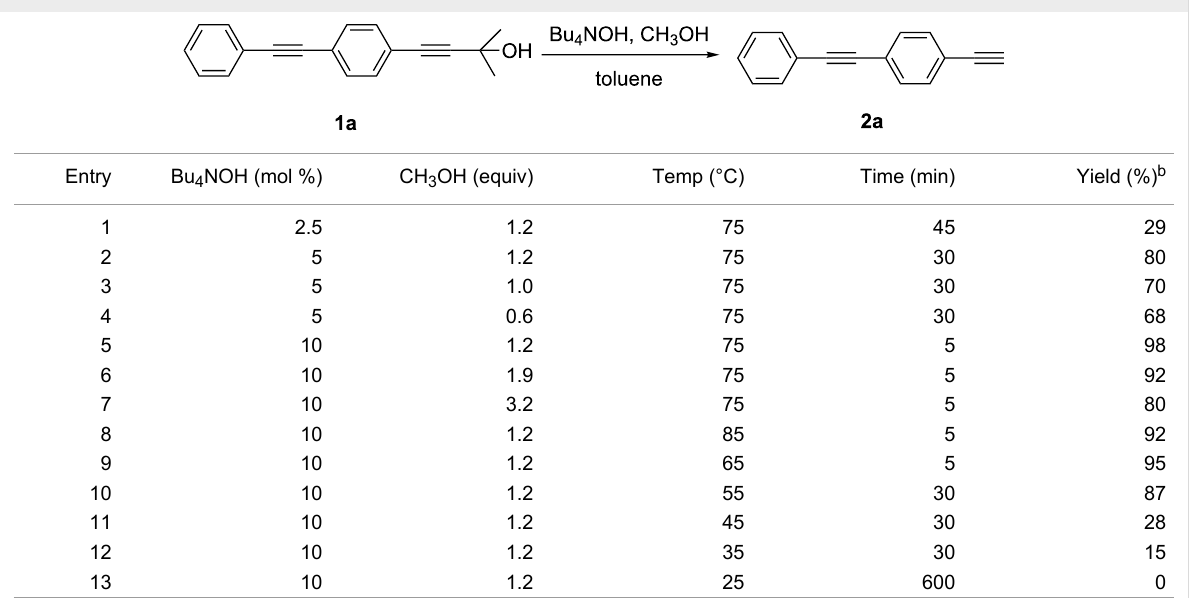
Table 2: Effect of reaction conditions on the yield of 2a .